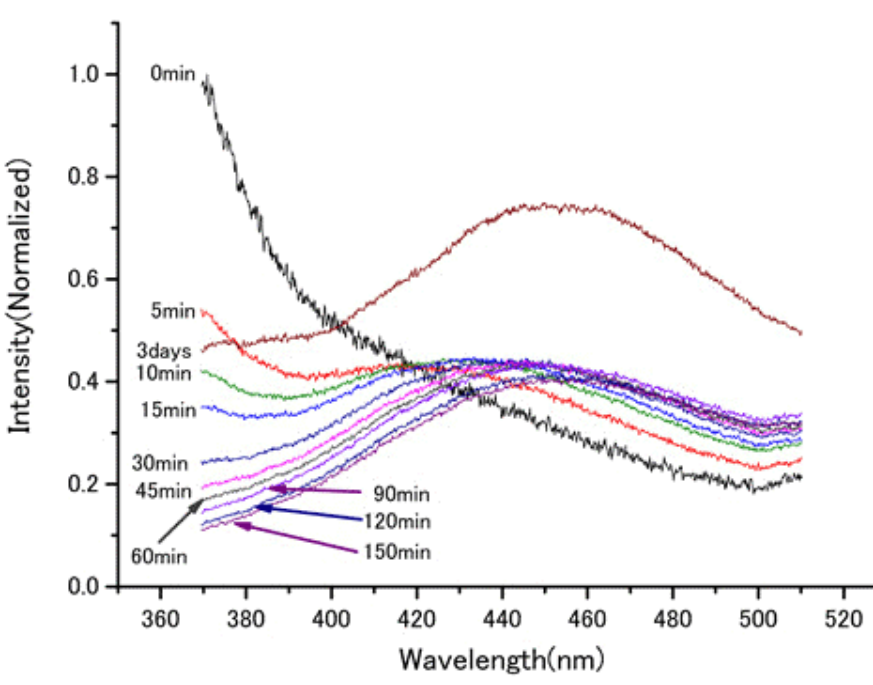
FIGURE 6 . Time variation of peak B. These spectra were measured with 10-nsec delay time.